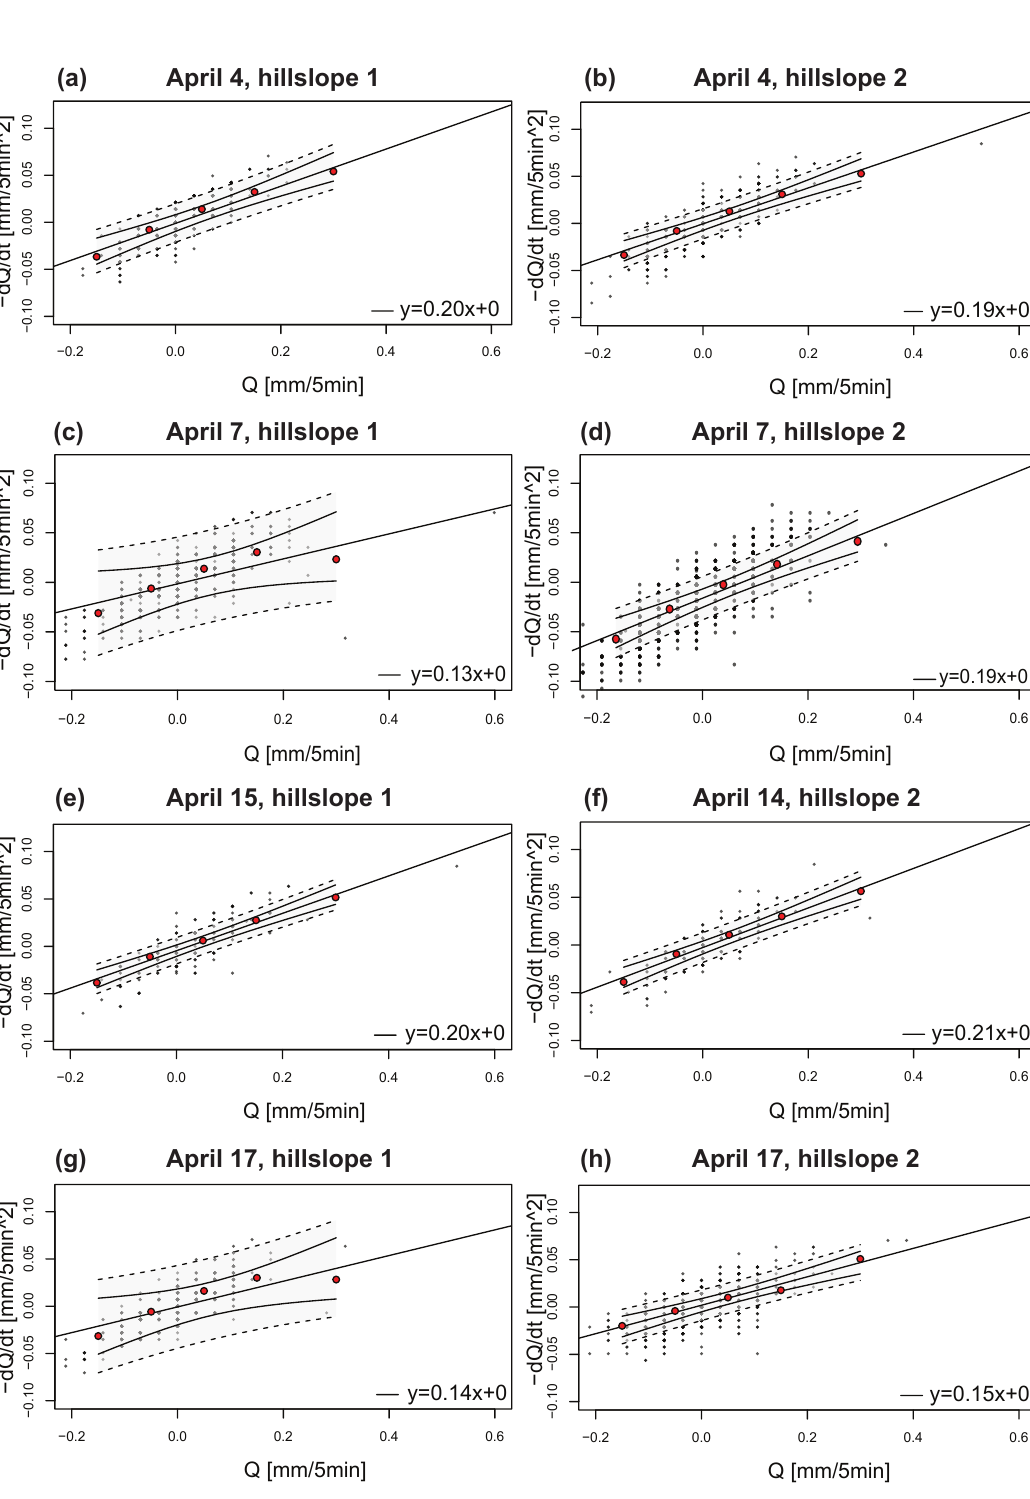
Figure 10. Flow recession rates (dQ/dt) as a function of flow (Q) for rainless periods on different days ( black dots, measured points) and for averages of dQ/dt, binned as described in the text ( red dots). The binned means ( red dots) deviate from the fitted lines by less than their standard errors, suggesting that the fitted lines are a quantitatively adequate description of the mean recession behaviour of hillslope 1 on: ( a ) April 4, ( c ) April 7, ( e ) April 15, and ( g ) April 17 and of hillslope 2 on: ( b ) April 4, ( d ) April 7, ( f ) April 14, and ( h ) April